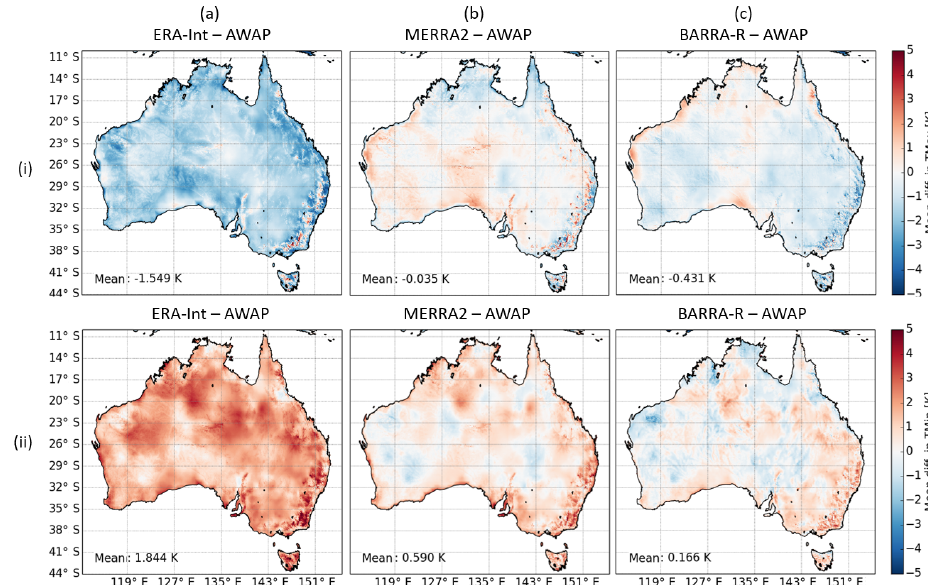
Figure 5. Mean differences in (row i) daily maximum (TMax) and (ii) minimum (TMin) 2m temperature (K) for 2007–2016 between (a) ERA-Interim and AWAP, (b) MERRA-2 and AWAP, and (c) BARRA-R and AWAP. The spatial means of the differences are reported in the text.